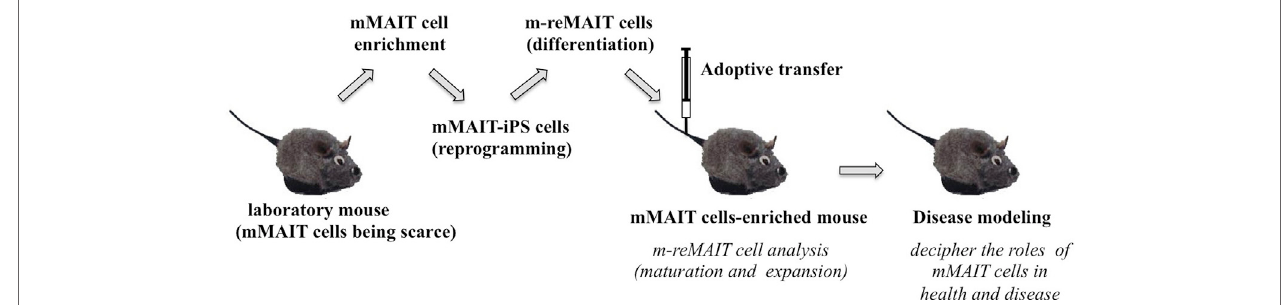
FiGURe 3 | A novel mouse model for studying the role of MAIT cells in health and disease. The strategy to generate mice rich in MAIT cells is summarized. Mouse (m) MAIT cells are enriched from laboratory mice (e.g., C57BL/6) by combination of cell surface antigens. mMAIT-enriched fractions are subjected to cell reprogramming to generate iPS cells. Induced pluripotent stem cells from mMAIT cells (referred as mMAIT-iPS cells) are differentiated into mouse MAIT cells (referred as m-reMAIT cells) via a standard T cell lineage differentiation protocol. Maturation and expansion of m-reMAIT cells are assessed in congenic mice upon adoptive transfer. Once m-reMAIT cells settle in congenic mice, mice could be used to model various diseases, such as infectious, autoimmune, and metabolic diseases, and cancer, to decipher the role of mMAIT